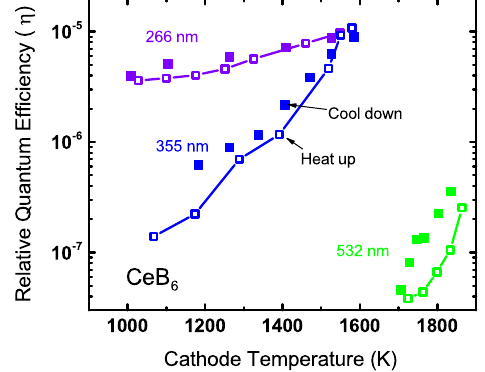
FIG. 13. Relative QE of CeB 6 which is obtained with 266, 355 and 532 nm laser irradiation as the function of the cathode temperature during heating up and cooling down